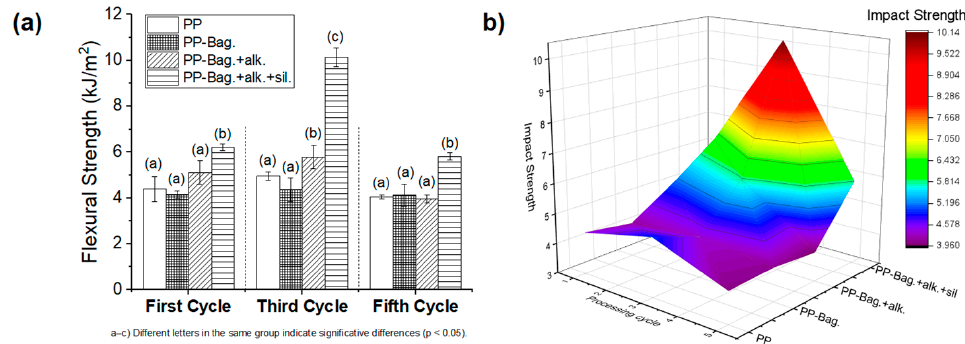
Figure 3. ( a ) Impact properties of PP and PP-Bagasse biocomposites and ( b ) 3D colormap surface of the impact properties.